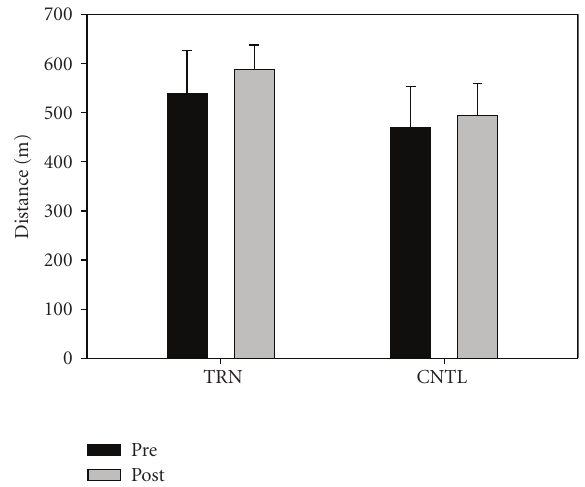
Figure 3: Six minute walk distance (m) for TRN (Pre = 537.7 ± 88.1, Post 586.9 ± 51.0) and CNTL (Pre = 468.8 ± 83.3, Post 493 . 9 ± 64 . 3). No significant interaction was noted ( P = . 296), but a significant time e ff ect was noted ( P = . 005).